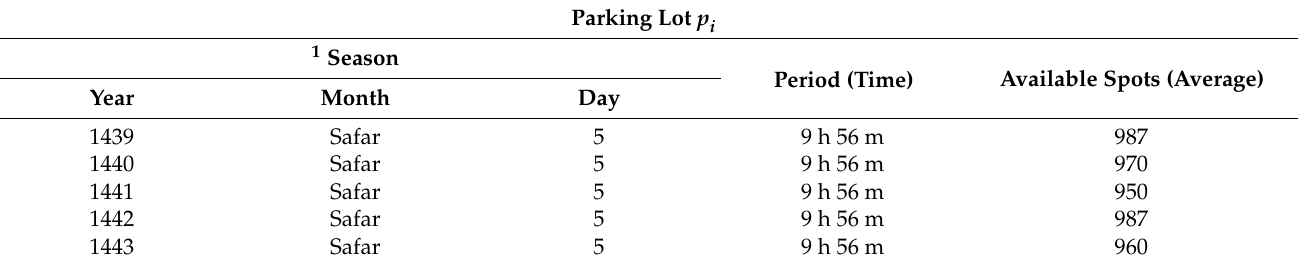
Table 3. Parking data